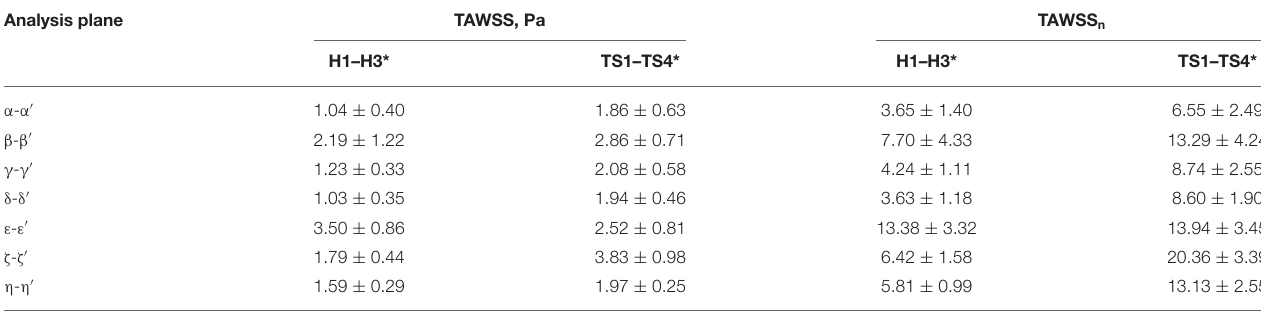
TABLE 4 | Time-averaged wall shear stress (TAWSS), expressed in Pascals (Pa), and normalized time-averaged wall shear stress (TAWSS n ) averaged over each analysis plane ( α - α ′ to η - η ’) for the healthy ( n = 3) and the Turner syndrome groups ( n = 4). Analysis